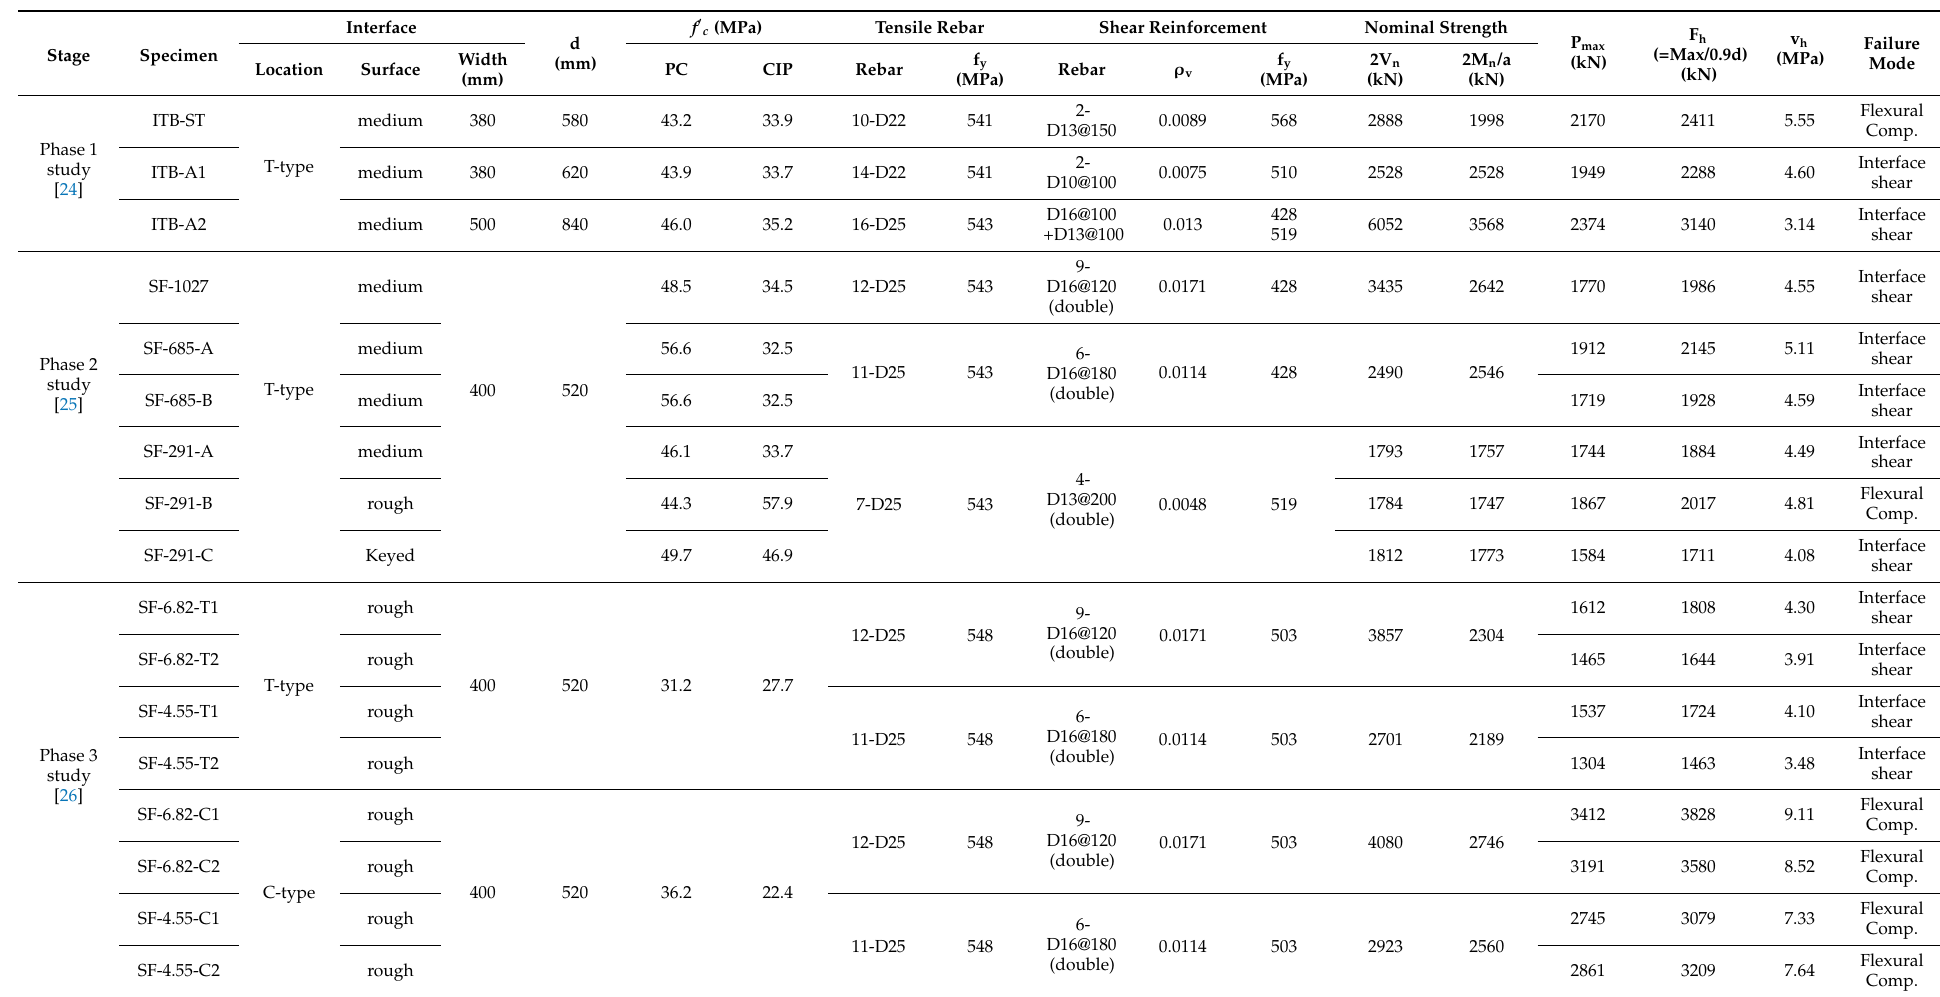
Table 1. Variables and test results of composite beam specimens in previous